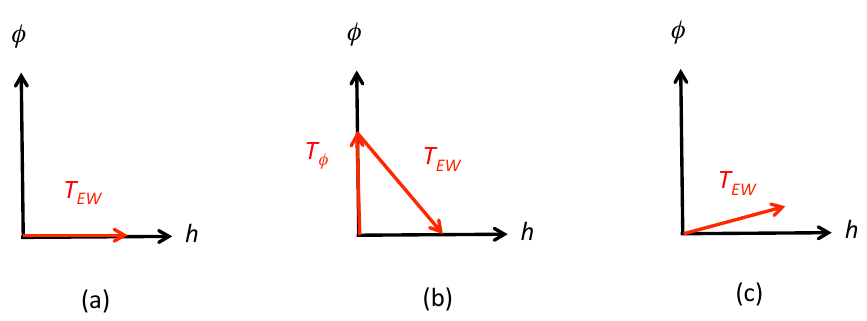
Figure 1 . Representative thermal histories of EWSB in the presence of the Higgs (cid:12)eld h and additional neutral scalar (cid:30) . (a) A one-step transition to the pure Higgs phase at temperature T EW ; (b) a two-step transition, with a (cid:12)rst step to the (cid:30) -vacuum at T (cid:30) > T EW followed by a second step to the pure Higgs phase; (c) a one-step transition at temperature T EW to the a mixed phase in which both h and (cid:30) have non-zero vacuum expectation